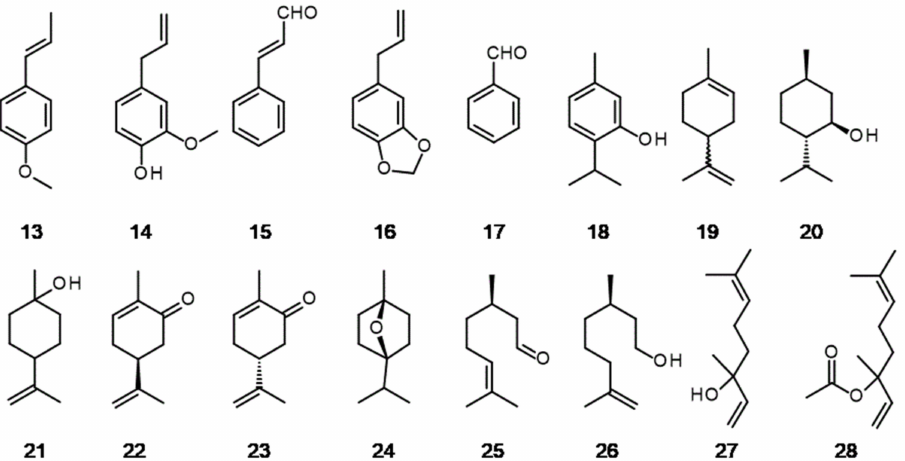
Figure 5. Some of natural isolates applied as food additives or perfume ingredients: ( 13 ) trans -anethole, ( 14 ) eugenol, ( 15 ) cinnamaldehyde, ( 16 ) safrole, ( 17 ) benzaldehyde, ( 18 ) thymol, ( 19 ) limonene, ( 20 ) menthol, ( 21 ) terpineol, ( 22 ) R -carvone, ( 23 ) S -carvone, ( 24 ) eucalyptol, ( 25 ) citronellal, ( 26 ) rhodinol, ( 27 ) linalool, ( 28 ) linalyl